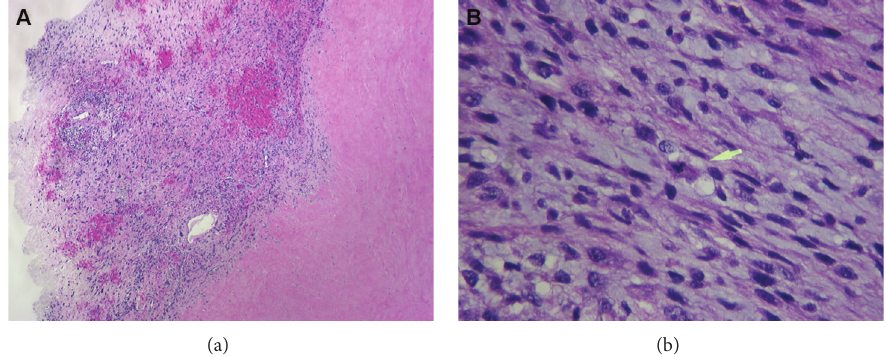
Figure 3: (a) Cellular neoplasm with infiltrative borders and necrosis ( × 10). (b) The high power ( × 40) reveals a cellular tumor with high nuclear/cytoplasmic ratio, irregular hyperchromatic, pleomorphic nuclei exhibiting high mitotic activity with abnormal mitosis and giant cells (arrow). Digital images captured with a digital camera (Olympus dp 20) attached to a microscope (Olympus b × 51).